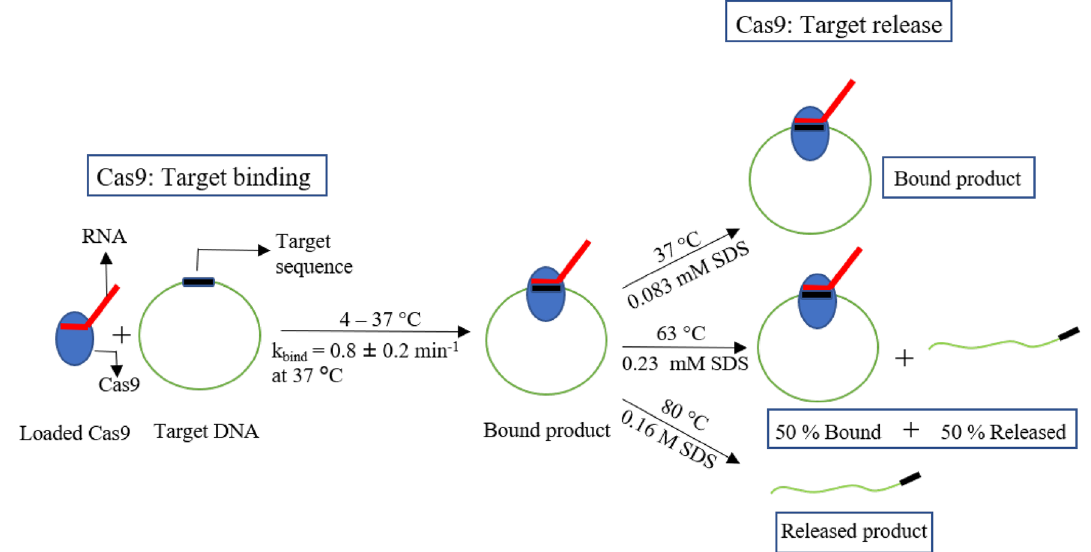
Figure 5. Schematic of Cas9 binding and release. Our data quantifies high temperature and SDS denaturant as two efficient pathways for Cas9 release of cleaved DNA. The green circle represents the target DNA and solid black rectangle on the target DNA denotes the target sequence, red line is the guide RNA and the solid oval blue represents the Cas9. We show that the Cas9.RNA complexes can efficiently bind to target DNA at temperature as low as 4 °C. The enzyme complex binds strongly to the cleaved DNA ends and can be released with high temperature (80 °C) or SDS denaturant (0.16